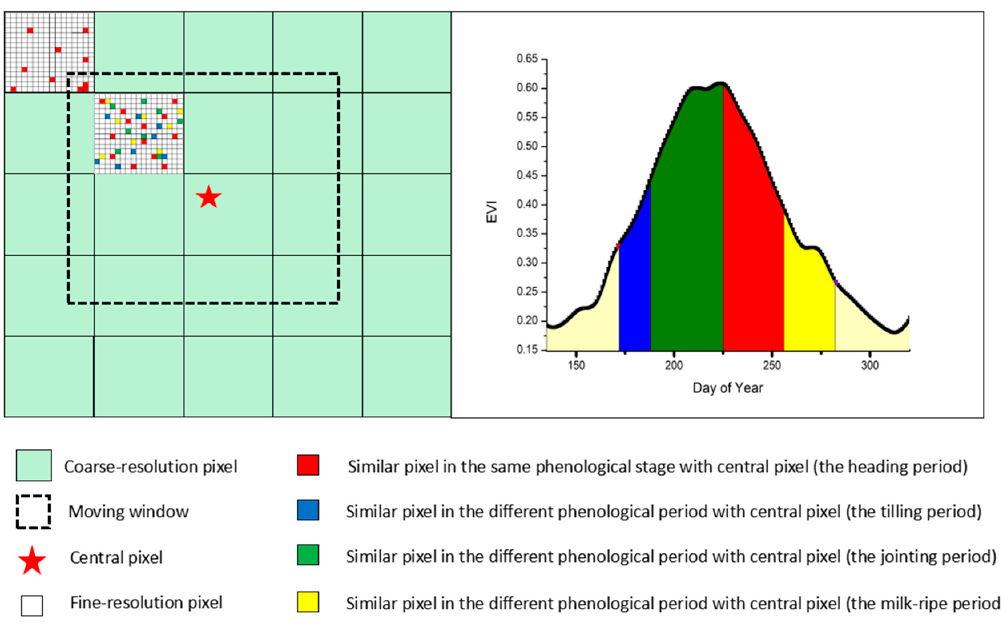
Figure 3. Schematic of selecting similar pixels within a same coarse-resolution pixel.